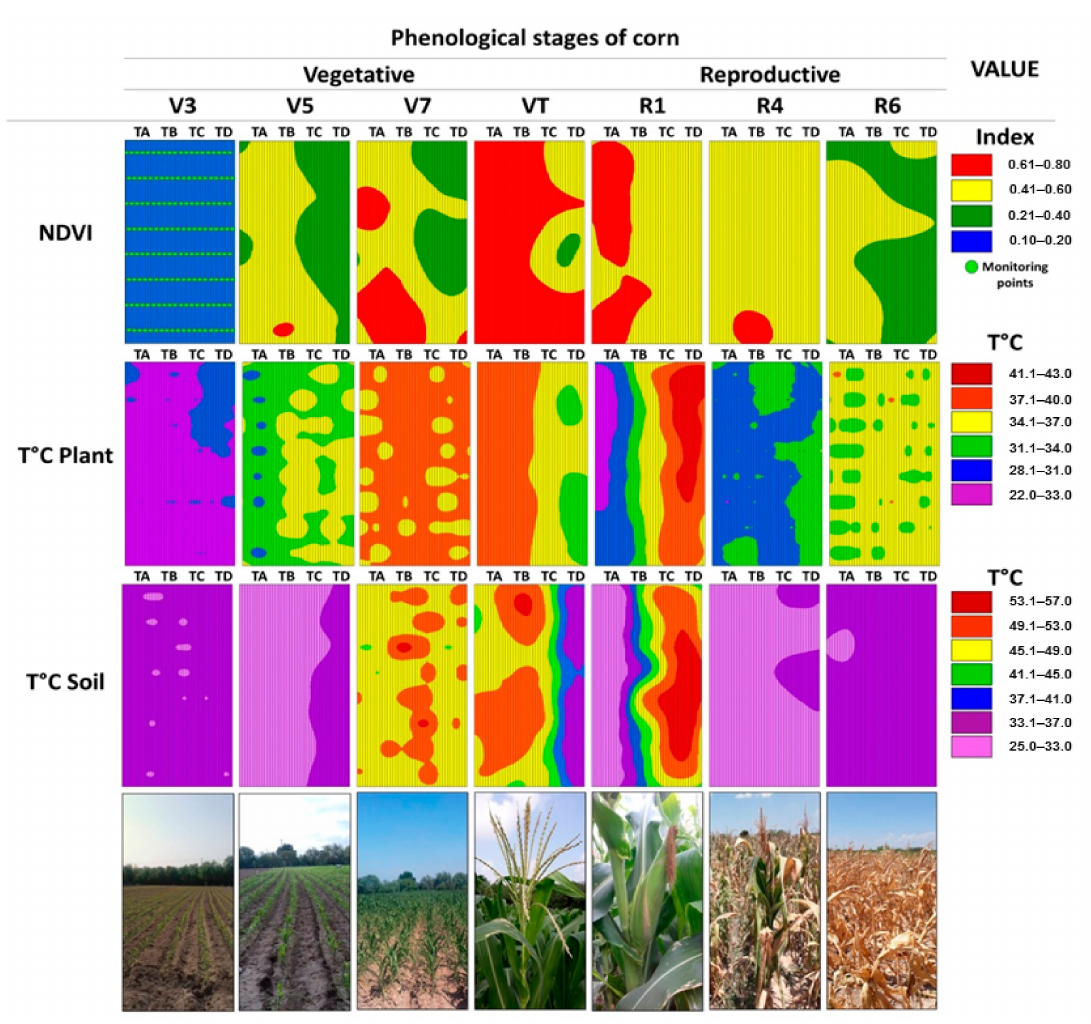
Figure 9. Representation of the normalized differential vegetation index (NDVI) values and tempera- tures for the plants and